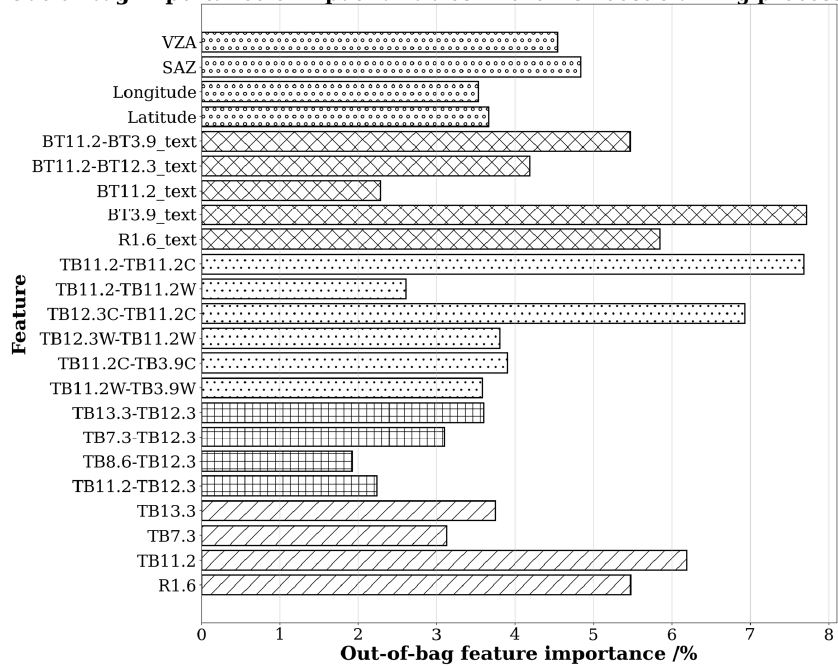
Figure 2. Out-of-bag importance of input variables in the XGBoost training